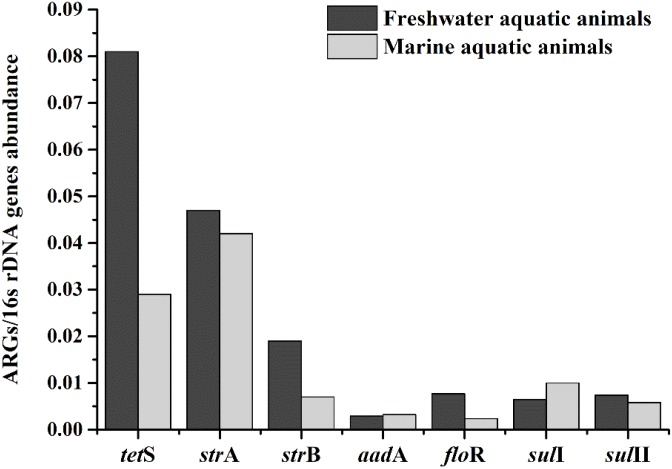
The average relative expression of seven prominent ARGs (tetS, strA, strB, aadA, sulI, and sulII) in freshwater aquatic animals and marine aquatic animals.